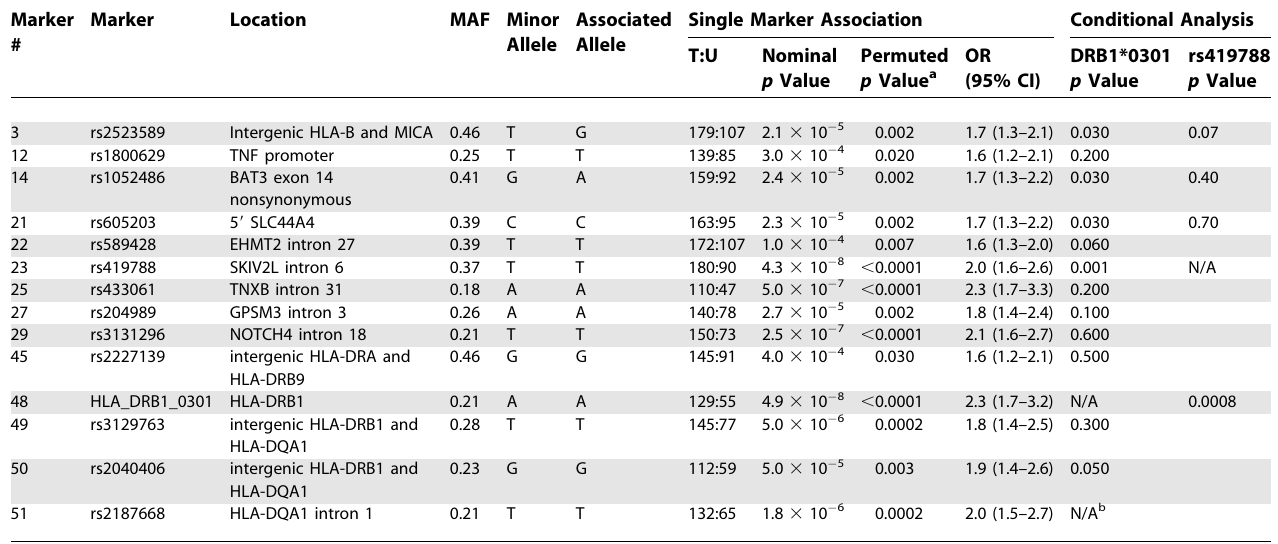
Table 1. Single Marker Association and Conditional Regression Analysis in 314 UK SLE Trios Marker Marker Location MAF Minor #